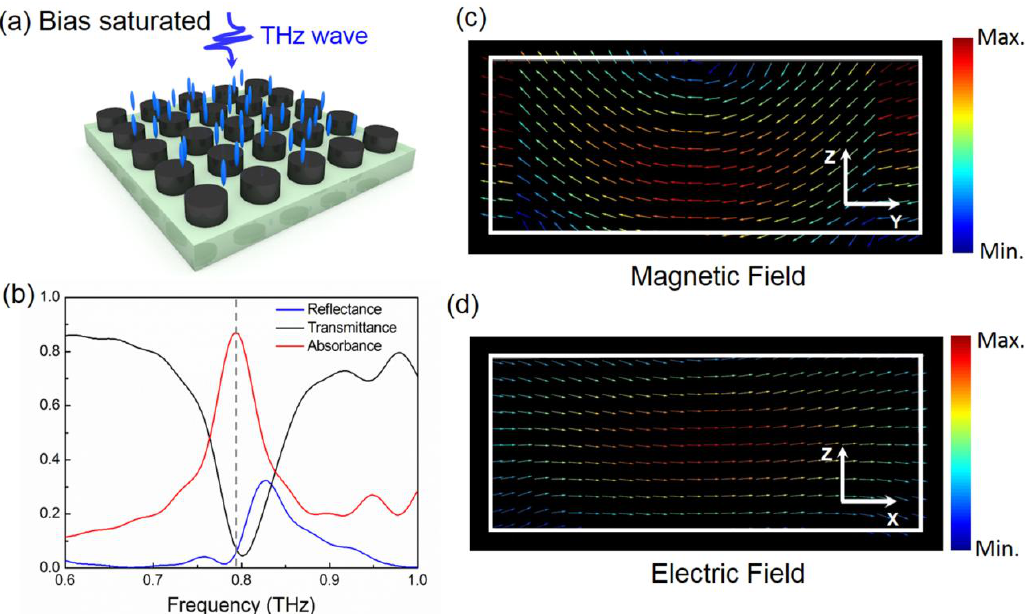
Figure 2. ( a ) The LC orientation in the bias saturated state. ( b ) Simulated spectra of reflectance, transmittance, and absorbance at bias saturated state. The ( c ) magnetic field of a single unit in the y - z plane, and ( d ) electric field in the x - z plane at 0.79 THz. The white rectangles in ( c , d ) represent the edge of the pillar unit, same hereinafter.